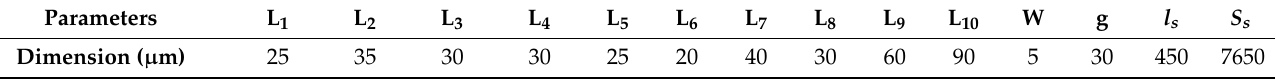
Figure 3. Geometric dimensions of ( a ) one segment unit cell (4th iteration) and ( b ) magnified view of the 2nd iteration of the unit cell antenna. Table 1. Optimum values for fractal geometric dimensions of the proposed reconfigurable antenna.